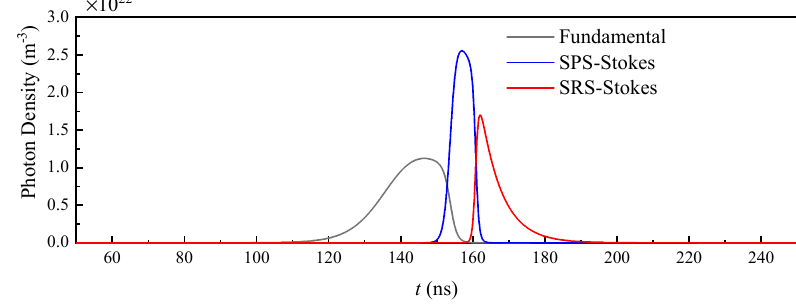
Figure 7. Calculated pulse evolutions of the SPS-SRS process.